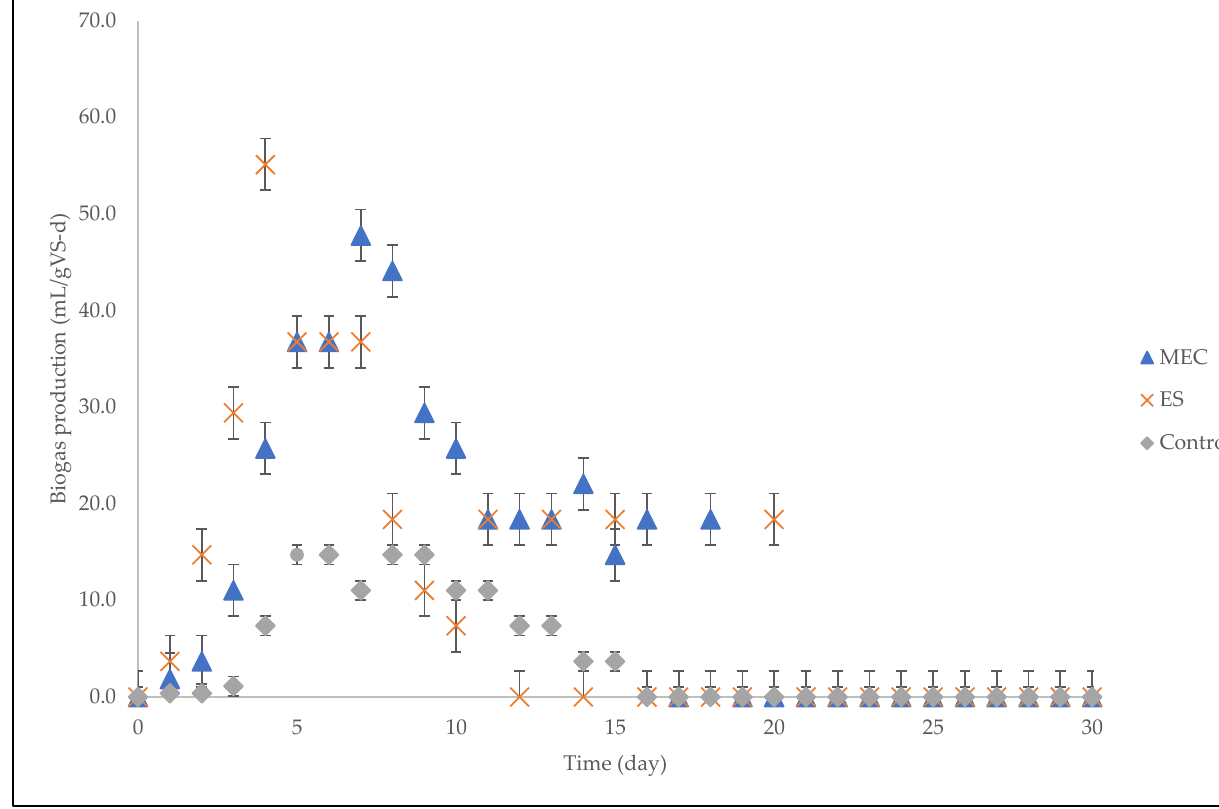
Figure 2. Daily biogas production over a hydraulic retention time of 30 days.